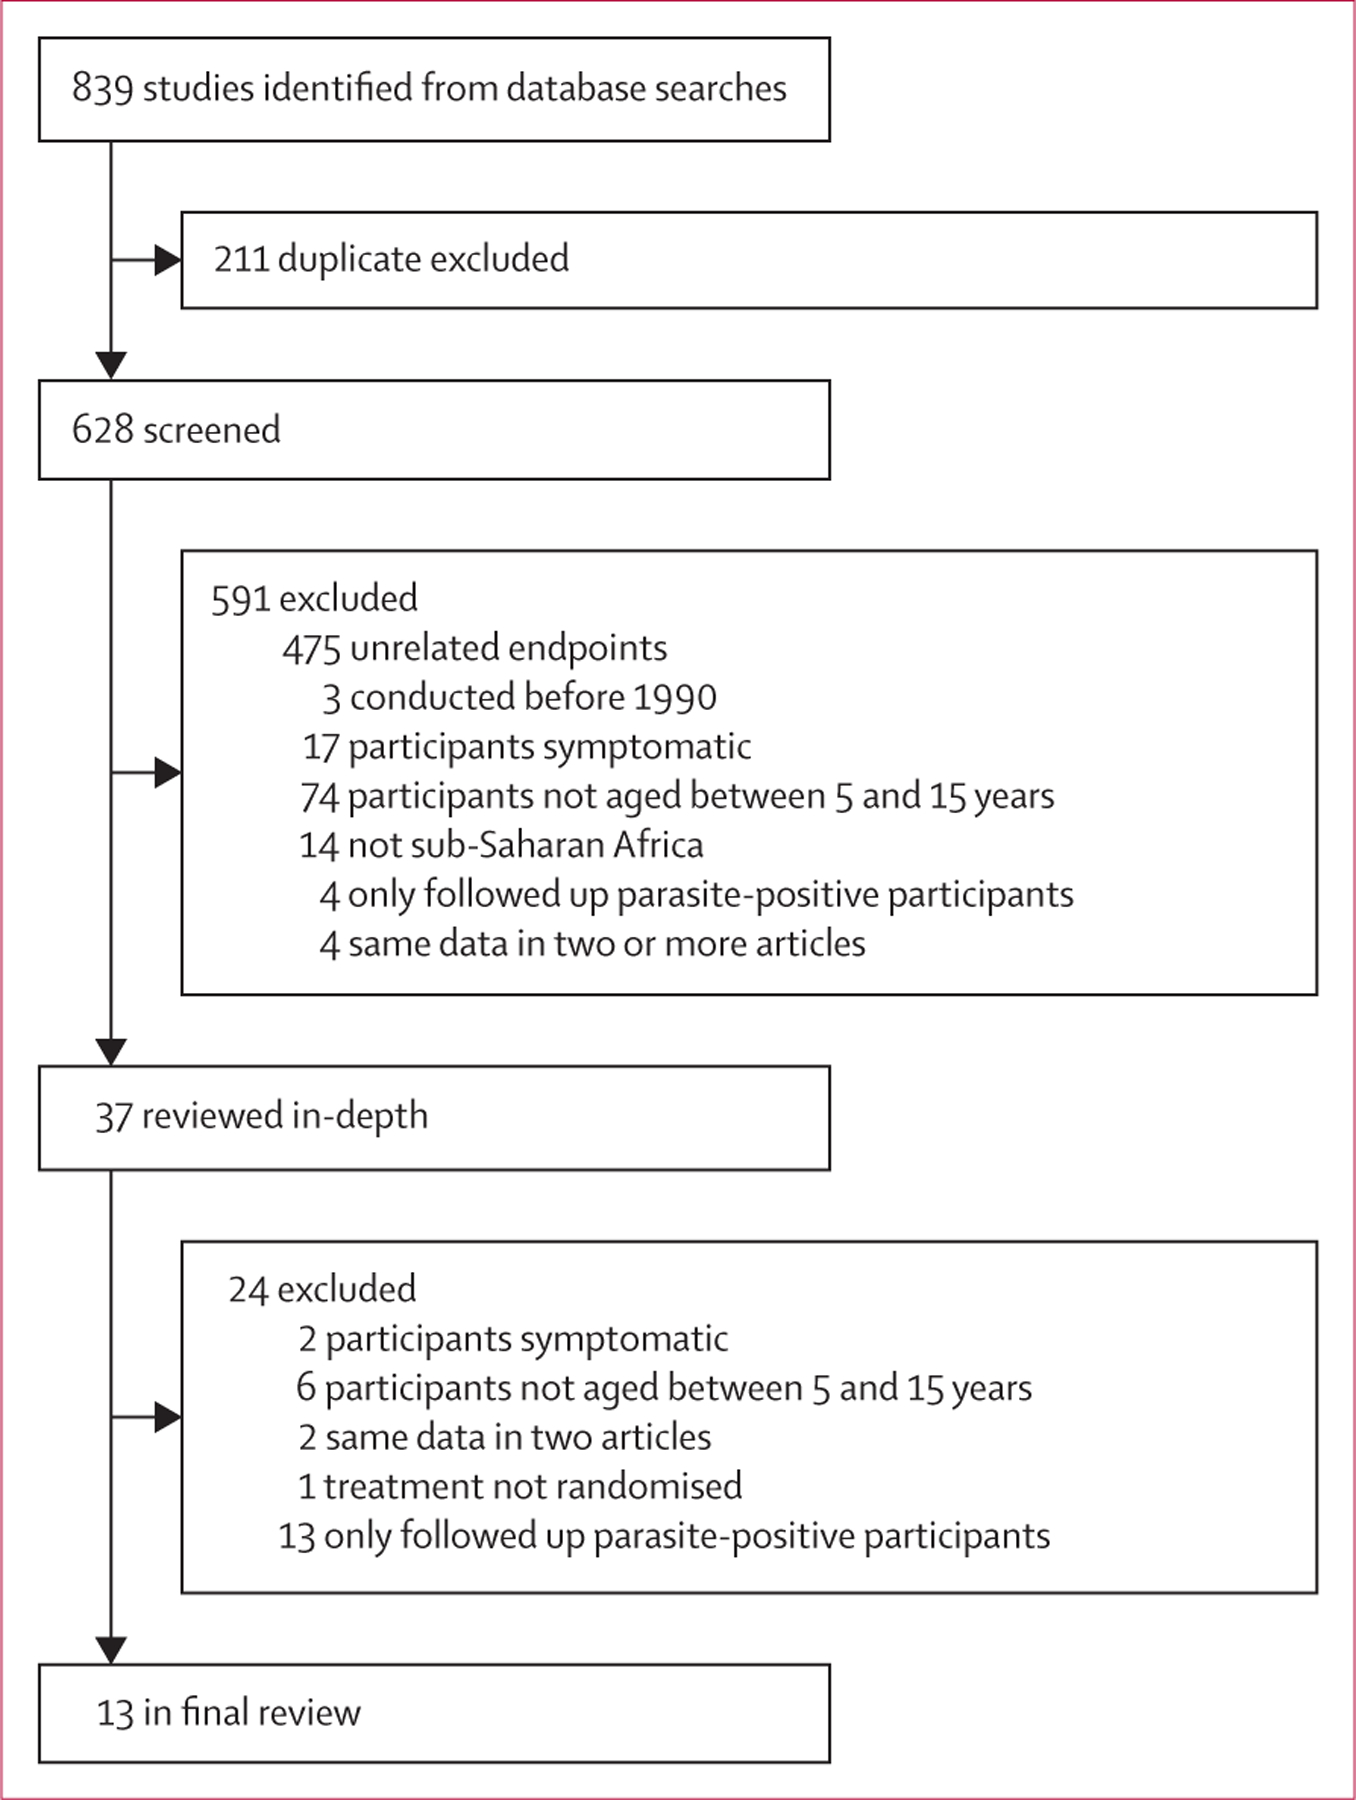
Study selection